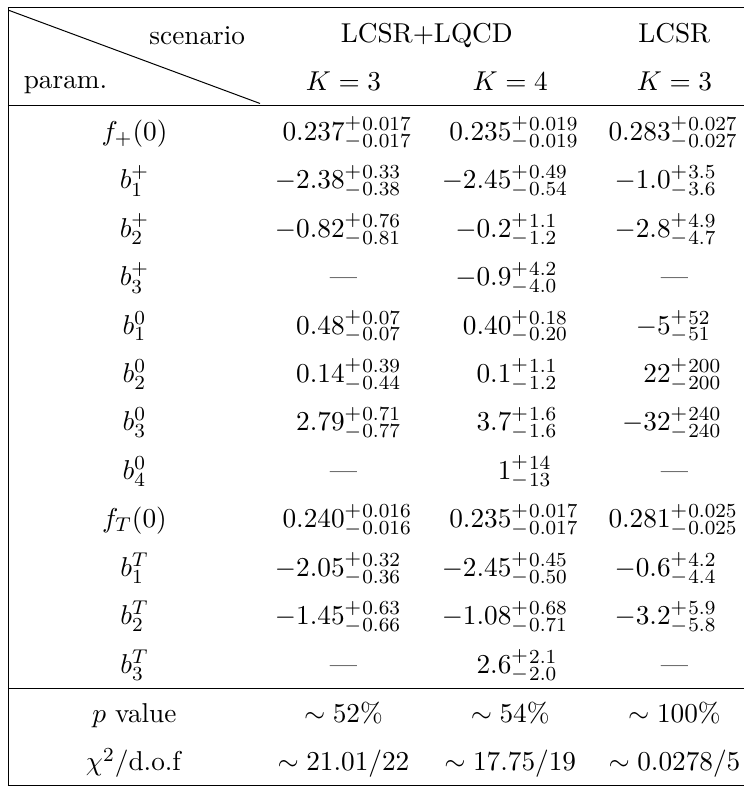
Table 5 . The median values and central 68% probability intervals for the parameters of the modified BCL parametrisation from eq. (4.1) when fitted to the LQCD and LCSR pseudo